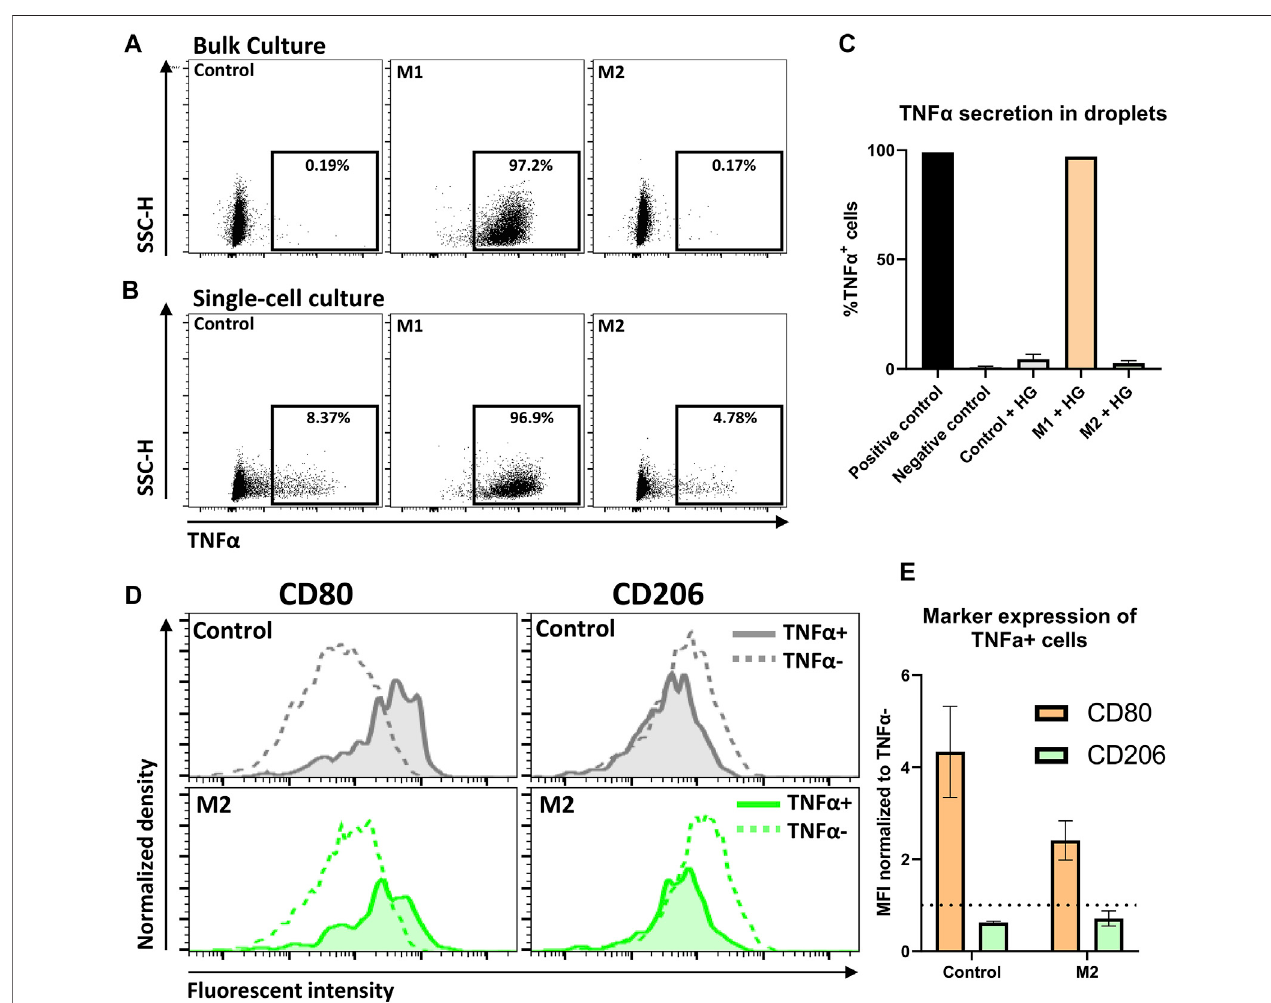
FIGURE 7 | Detection of TNF α secretion by single-cell polarized macrophages. (A,B) Dot plots representing TNF α secretion of Control, M1 and M2 stimulated macrophages in bulk and droplets, respectively. Gating for TNF α was based on a positive control. (C) expression of TNF α on macrophages after 2-day culture in hydrogeldroplets.ResultsrepresentmeanofControl: n (cid:2) 3donors,M1: n (cid:2) 2donorsandM2: n (cid:2) 3donorsandnegativecontrol: n (cid:2) 3,positivegateisbasedonpositive control. (D) Histograms comparing expression of markers for M1 (CD80) and M2 (CD206) polarization between TNF α − cells and TNF α + cells. Histograms show control and M2 cells from one donor cultured for 2 days in hydrogel droplets. (E) Bar graph comparing CD80 and CD206 expression between TNF α − and TNF α + cells from hydrogel droplet cultured control and M2 cells. Bars represent MFI of TNF α + population normalized to TNF α − population for n (cid:2) 3 donors.